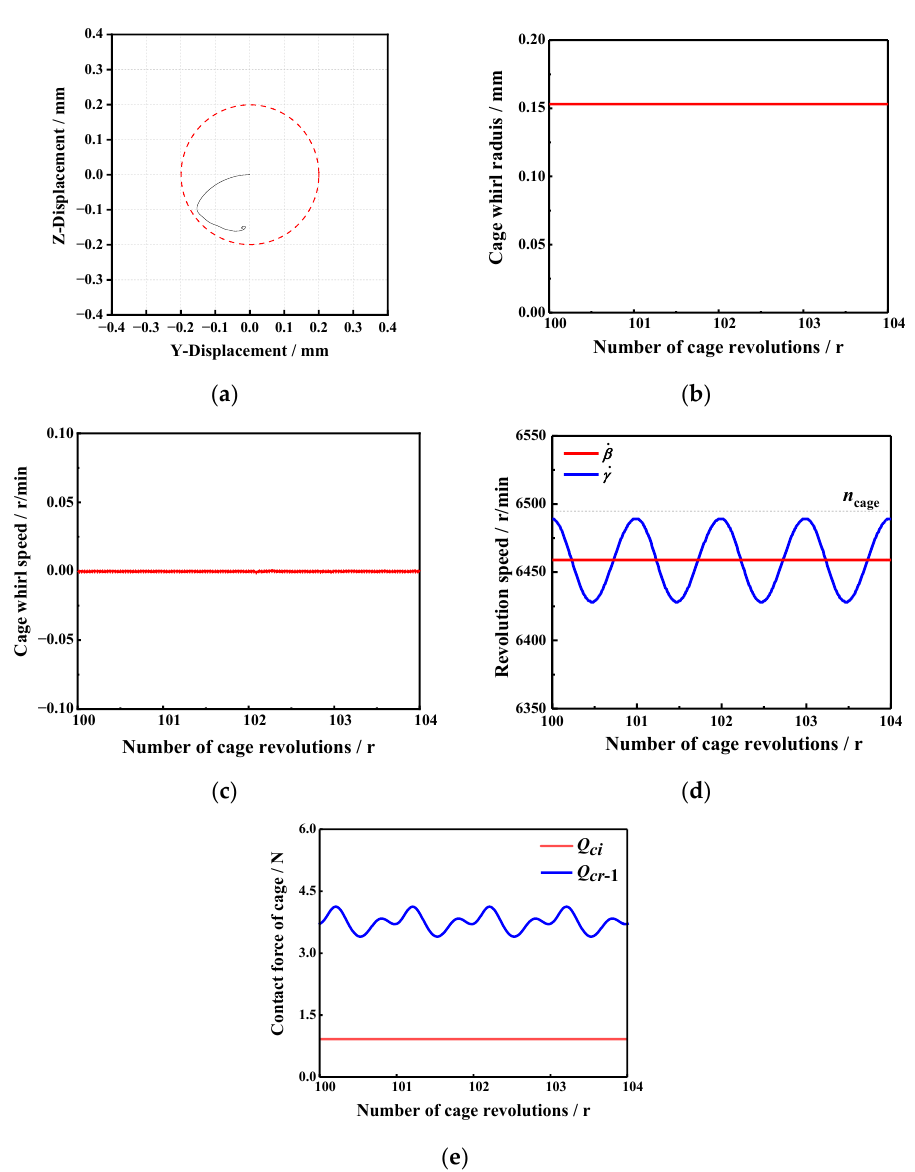
Figure 8. Whirl parameters and force of the cage under operating condition 2: ( a ) whirl orbit; ( b ) whirl radius; ( c ) whirl speed; ( d ) rotational speed of rollers and cage; ( e ) force on cage. The cage mass center under operating condition 3, shown in Figure 9, has a fixed and periodic whirl orbit in a local area within circle (cid:12) center . The cage whirl radius r c and whirl . α both vary periodically. At this time, the bearing center O is outside the whirl range speed . α has some negative values. It can be regarded of the cage mass center, so the whirl speed as the cage mass center around the point (–0.015, –0.115) to carry out periodic motion, the motion radius and the motion speed, as shown in Figure 9d,e. It can be seen that the motion radius and motion speed of the cage mass center also vary periodically. From the motion . . β varies in a small amplitude period, and γ varies similarly speed of the cage and roller, to operating condition 2 but is not completely sinusoidal, corresponding to Q cr − 1 and Q ci , which show a periodic variation, but the amplitude of each period of Q cr − 1 is